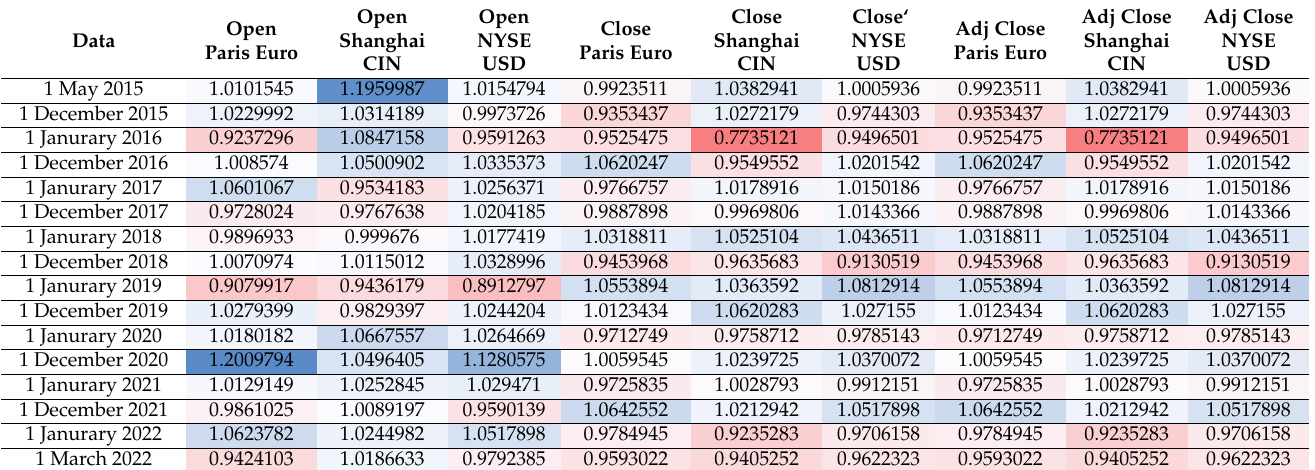
Table 1. Monthly changes in the quotations of the composite